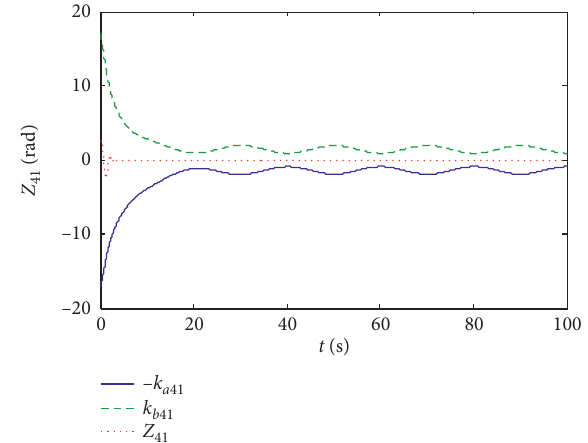
Figure 12: Constraint effect of Z